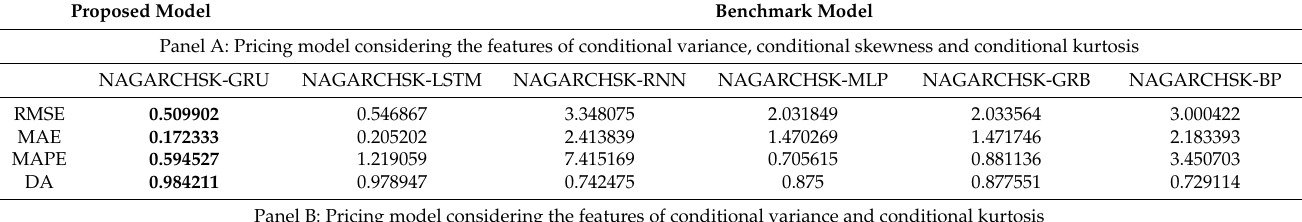
Table 3. Performance of the proposed and benchmark model for forecasting the carbon price.